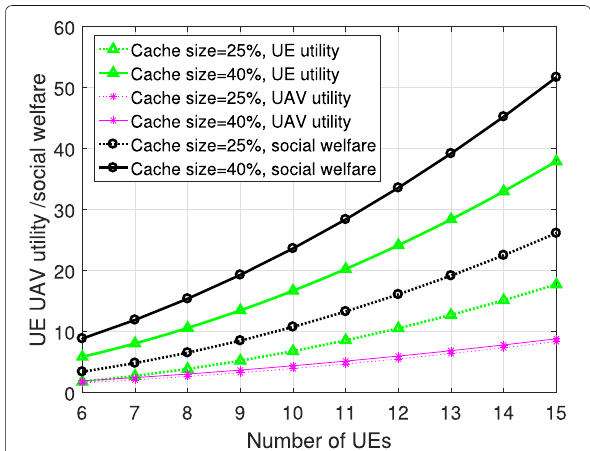
Fig. 6 UE and UAV utility, and social welfare versus the cache size and number of